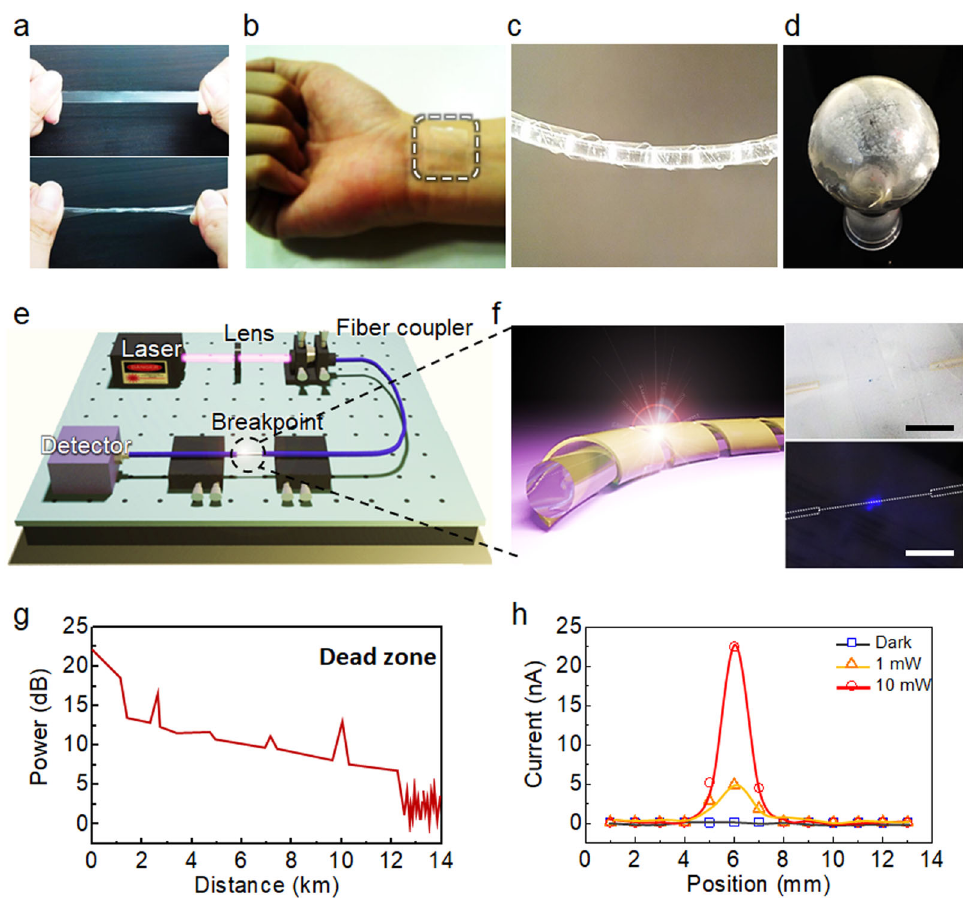
Fig. 5 a The PD being stretched and twisted. b The fl exible PD device attached to skin, ( c ) wrapped on a light-emitting diode tube (the scale bar is 1 cm), and ( d ) stuck to the surface of a sphere. e The experimental setup to detect a leaky point in an optical fi ber. f An illustration of the PD array wrapped on a fi ber and the optical images of the fi ber and PD arrays (the scale bar is 1 cm). g A scheme describing the dead zones of the OTDR technique. h The photoresponse of the PD array under dark and different laser power illuminated